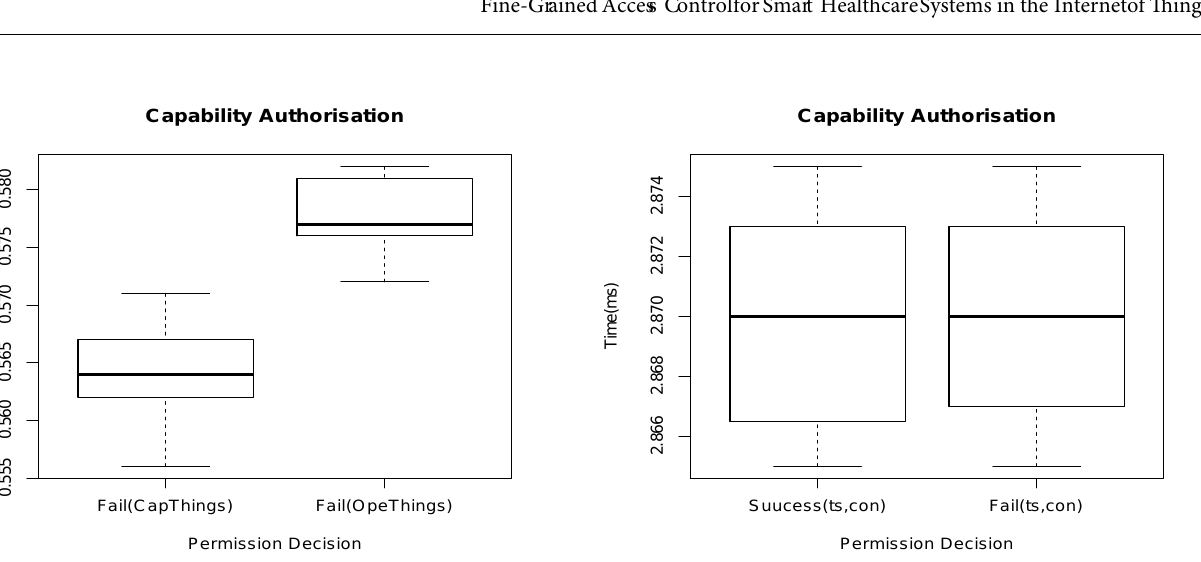
Figure 9. The capability authorisation time for an invalid capability.‘Fail(CapThings)’denotesthat the capabilitydoes not applyto the thing . ‘Fail(OpeThings)’denotesthat the capability does notallowa validoperationonthe thing . Note, in boththe cases the timestampis valid.